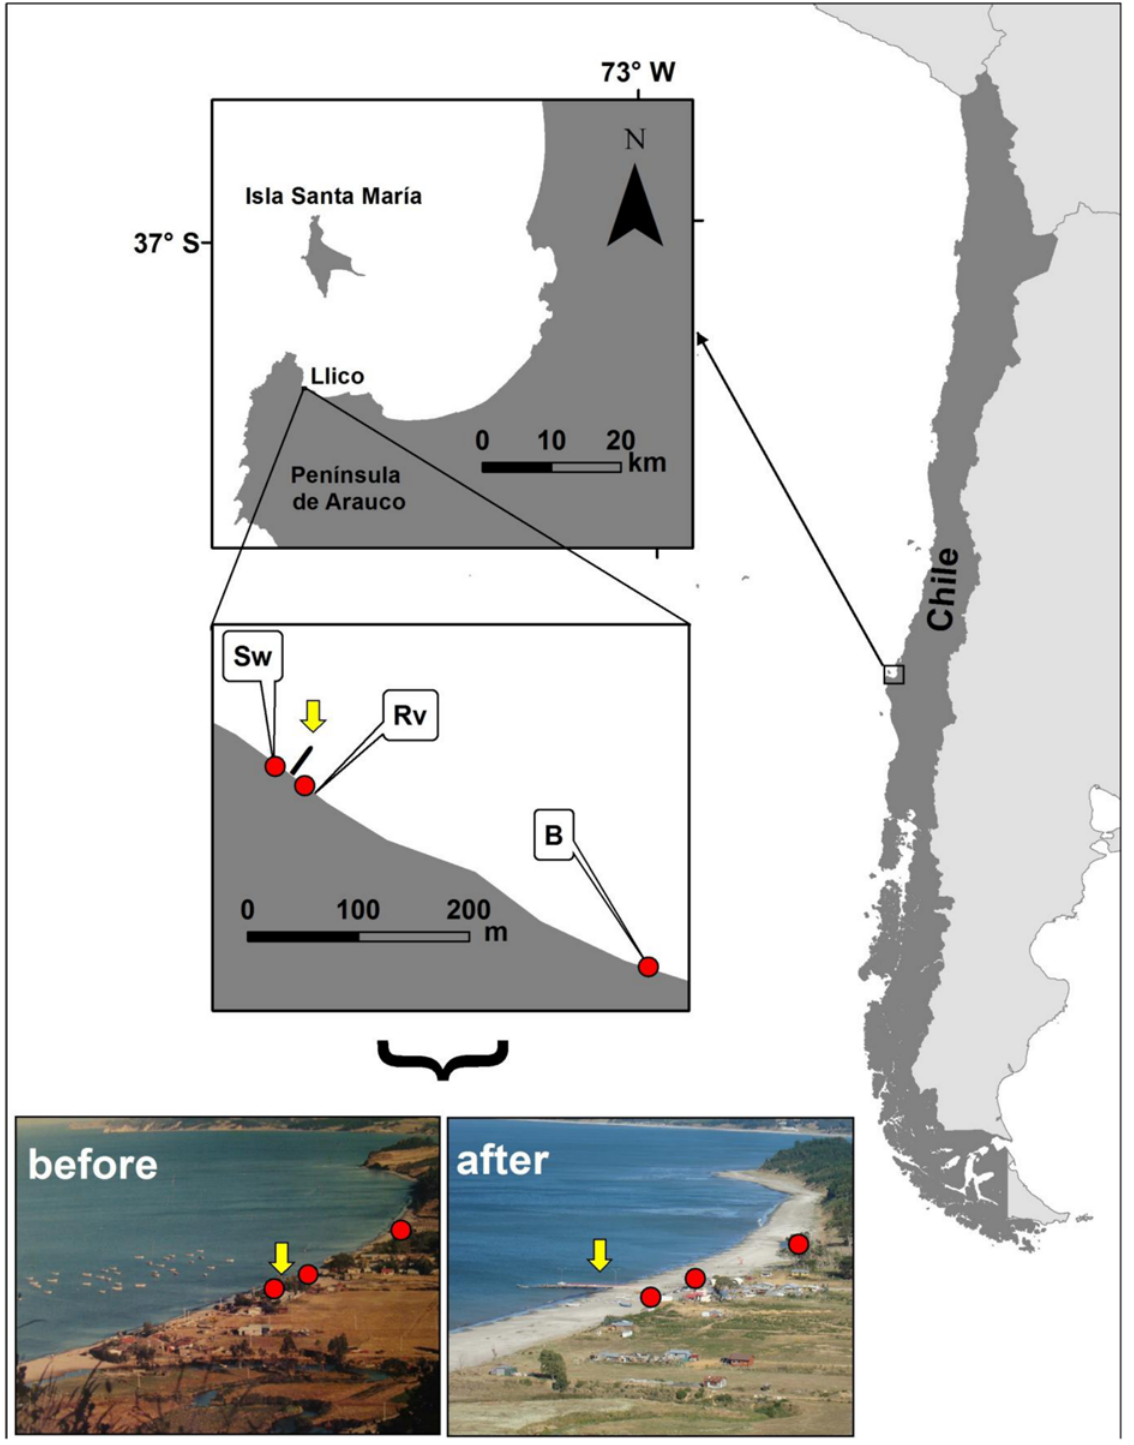
Fig 1. Location of the study sites at the beach of Llico, south central Chile. Before (July 2009) and after (December 2011) Maule earthquake (27 th February 2010) pictures of Llico are presented to show approximate locations (red dots) of sandy sites in front of the seawall (Sw) and the rocky revetment (Rv), as well as that of the unarmoured beach (B). Yellow arrows indicate location of a jetty in relation to low tide level. Note differences in intertidal width before and after the earthquake.